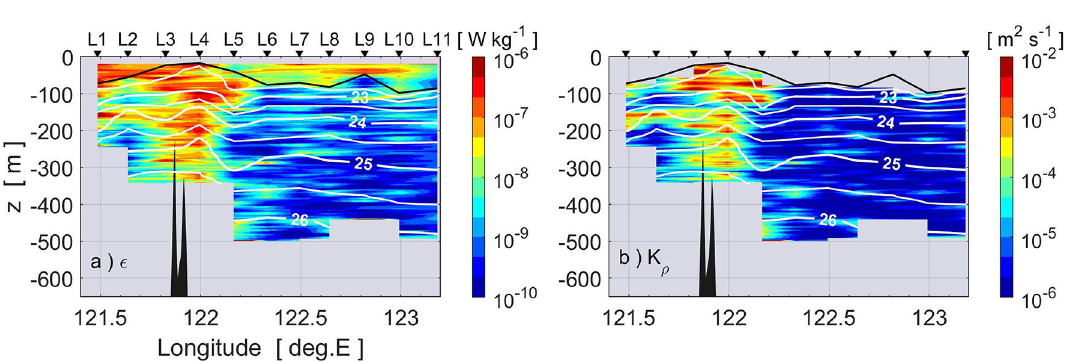
Figure 3. Vertical section of ( a ) TKE dissipation rate ε and ( b ) vertical eddy diffusivity K ρ estimated by TurboMAP-L and VMP-2000 profilers from L1 to L11 on 25–26 November, 2017. Contour lines show isopycnals of potential density (σ θ ). The thick solid line indicates the base of the surface mixed layer, where potential density deviates by 0.03 kg m −3 from the uppermost density observations. Dark shading represents the bottom topography along the ship track from a shipboard